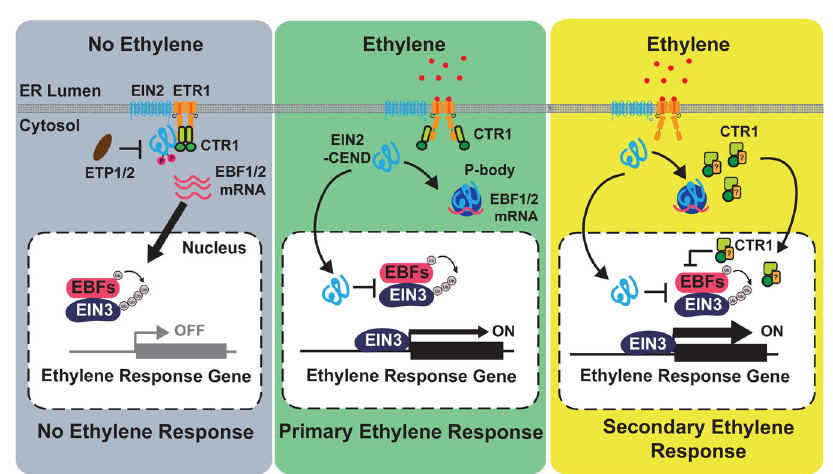
Fig.7|Modelforethylene-inducedCTR1nucleartranslocationandstimulation of the ethylene response. In the absence of ethylene, the ethylene receptors, CTR1, and EIN2 mainly localize to the ER. Receptor-activated CTR1 phosphorylates EIN2, thus leading to the proteolytic degradation of EIN2 via EIN2-TARGETING PROTEIN 1 (ETP1) and ETP2. In the presence of ethylene, the receptors, and hence CTR1, are inactivated. Inactivated CTR1 no longer phosphorylates EIN2, and the C-terminal domain of EIN2 (EIN2-CEND) is proteolytically cleaved and translocates to the nucleus, where it initiates the primaryethyleneresponse viaEIN3